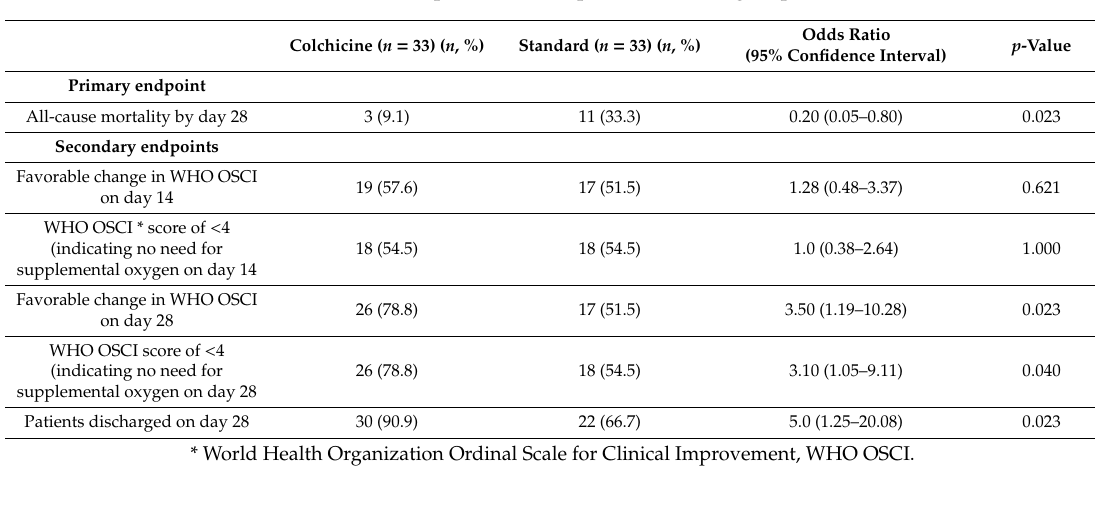
Table 2. Comparison of endpoints between groups.